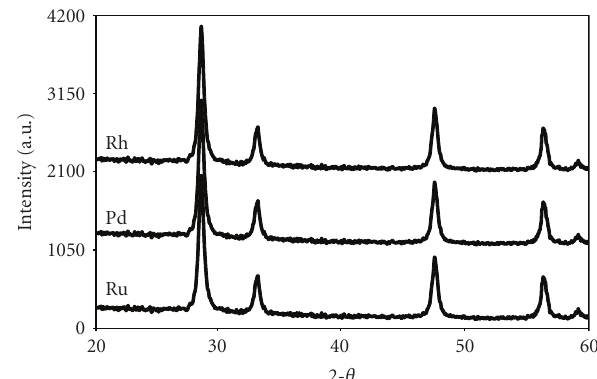
Figure 5: XRD patterns of the catalysts sulfided for 24h at 800 ◦ C in 1000 ppm H 2 S/bal. N 2 .